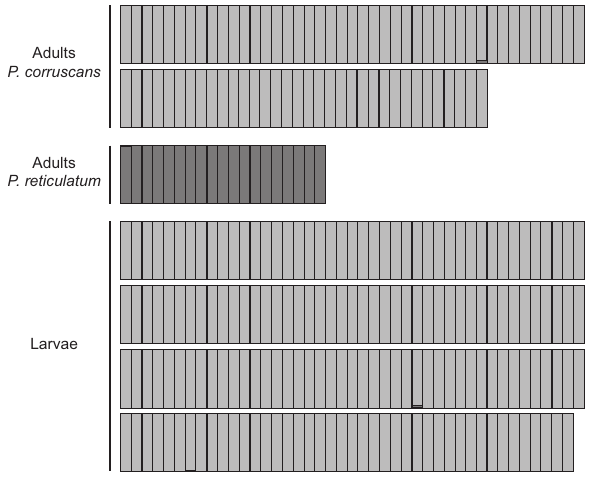
Figure 1. Genetic assigment of adults of Pseudoplatystoma corrus- cans and P. reticulatum and larvae sampled in the Upper Paraná River basin. Each column represent an individual and each color represent a : 2012-2013, N : 2013-2014, N : 2014-2015, N :2015- 1 2 3 4